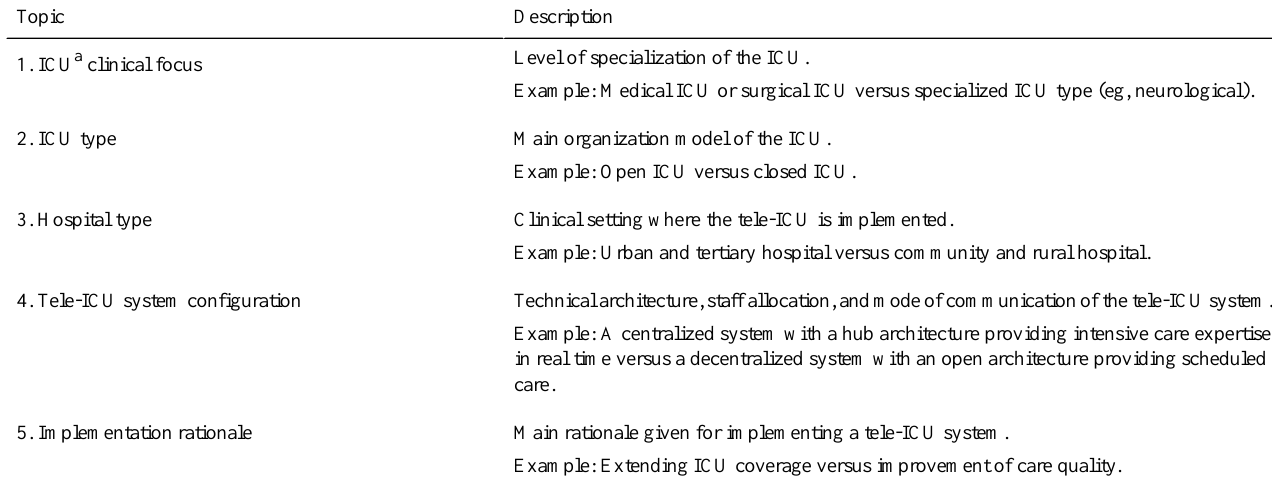
Table 2. Overview of data extraction